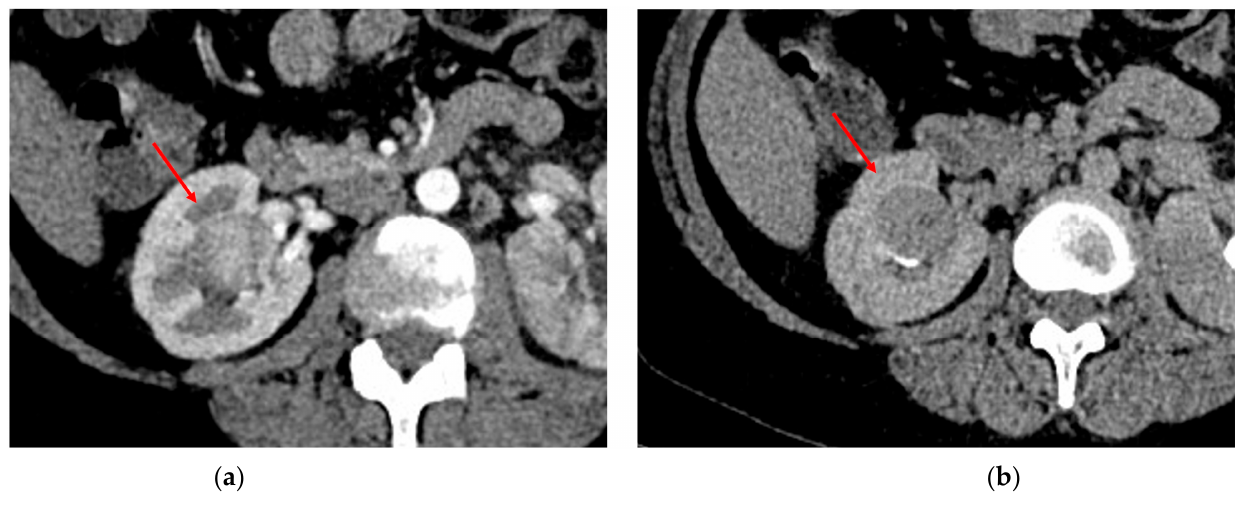
Figure 3. Example of endophytic malignant renal cell tumor with pseudocapsule (red arrow) at CECT in nephrographic phase ( a ) and urographic phase ( b ).